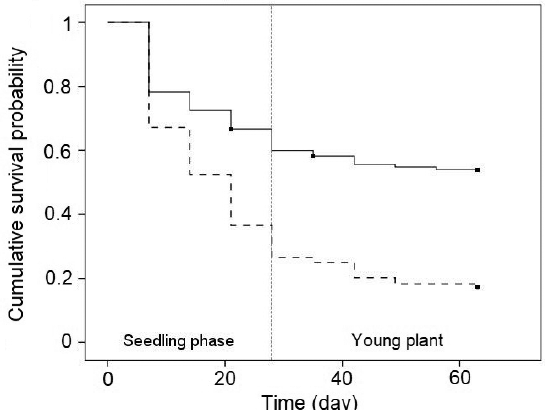
Figure 3. Differences in survival probabilities for E. lobata seedlings and young plants for single (solid line) and aggregated seedlings (dotted